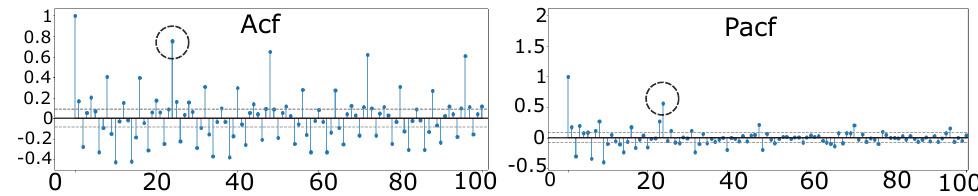
Figure 4. Autocorrelation and partial autocorrelation